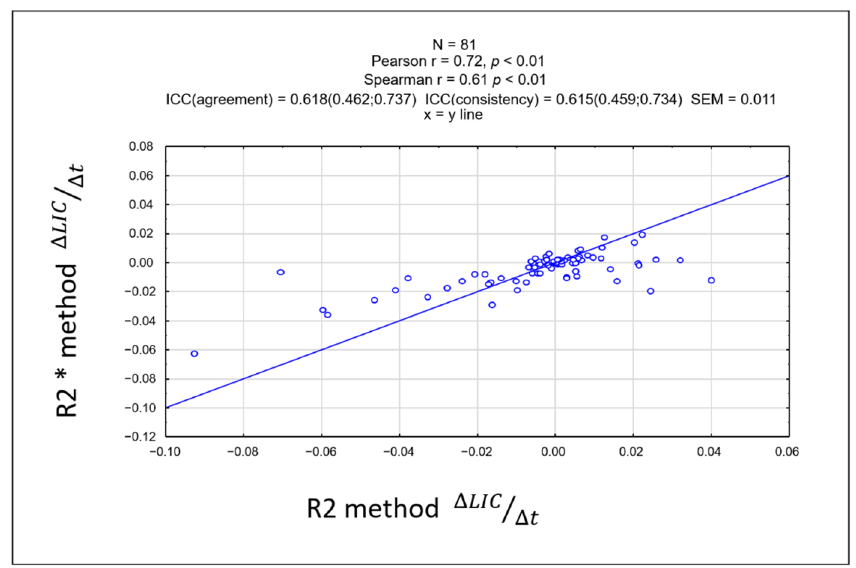
Figure 4. Scatterplot of the rate of change of liver iron concentration (LIC) showing a strong linearity between the R2* and R2-based methods with a correlation coefficient of r = 0.72. This suggests that there were no significant differences in the rate of change of LIC between the two methods.